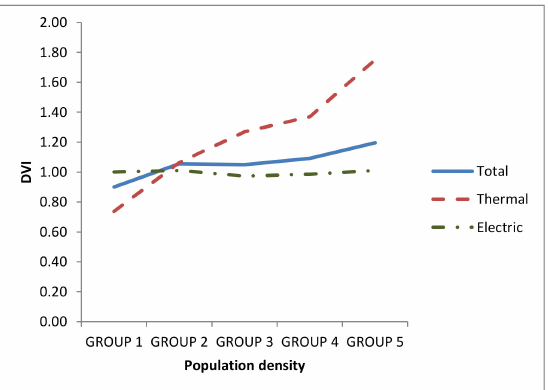
Figure 12. Variation of the DVI index for energy consumptions per inhabitant by group of cities without the influence of